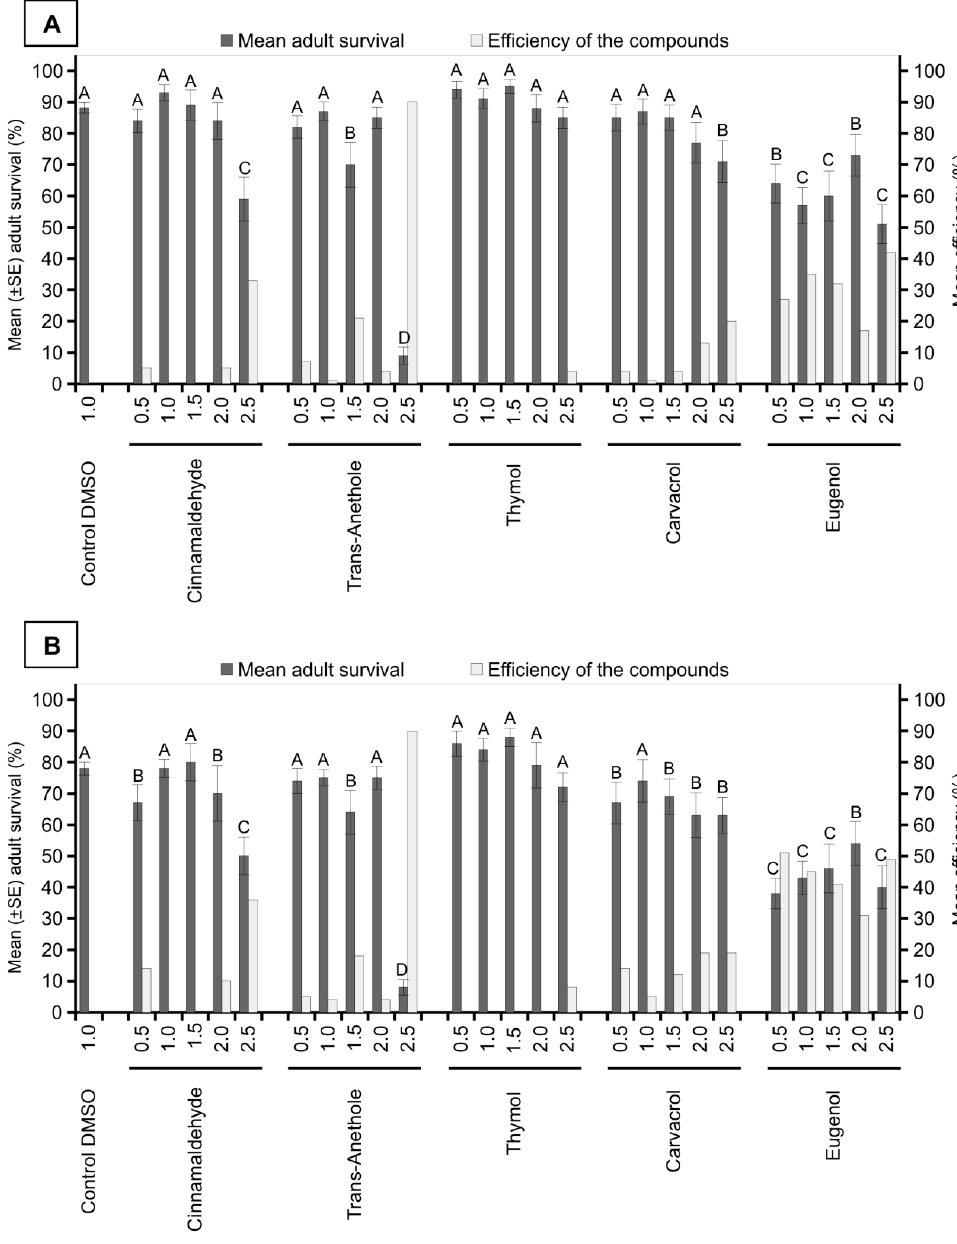
Figure 3. Insecticidal activity of compounds of plant origin (concentrations of 0.5%, 1.0%, 1.5%, 2.0%, and 2.5%) against M. spectabilis adults after 24 ( A ) and 48 h ( B ) of application. The control efficiency of the treatments was calculated using the Abbott formula. Di ff erent letters in the columns